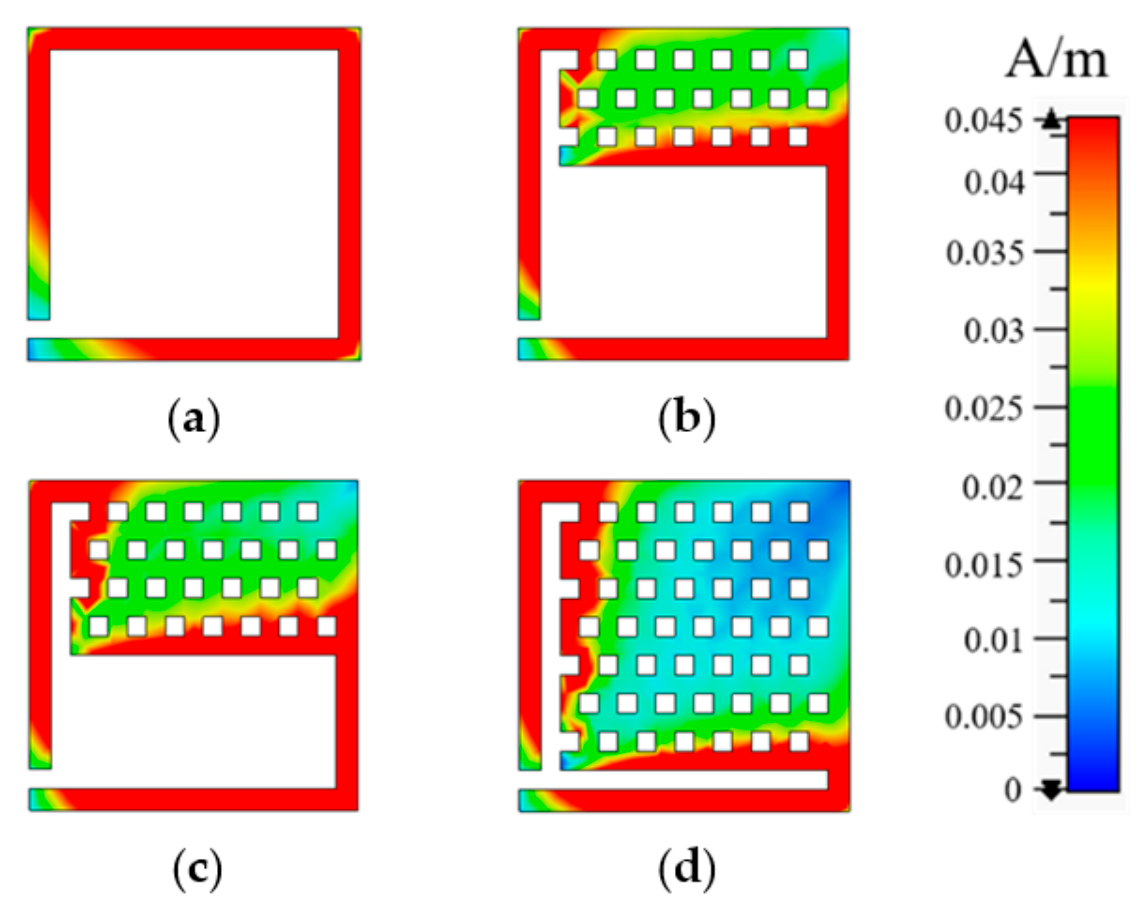
Figure 5. Current distribution of open-loop resonator: ( a ) 7.5 GHz; ( b ) 8.9 GHz; ( c ) 9.5 GHz; ( d ) 10.89 GHz.